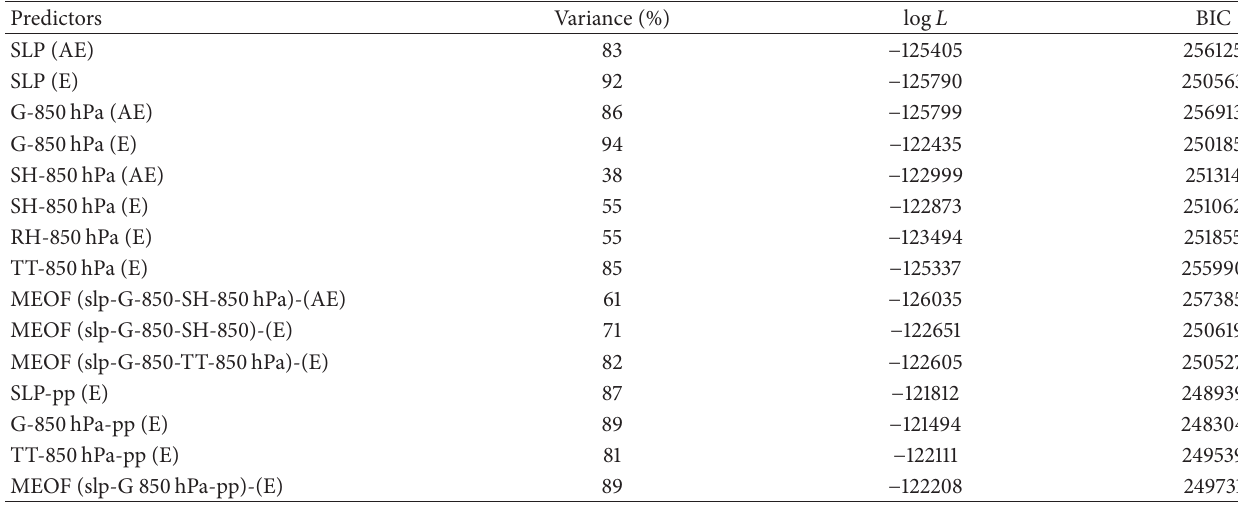
Table 3: Fitting by NHMM with seven states of precipitation at the 19 stations, taking into account as predictors (first 10 PCs) for EOF or MEOF decomposition; log 𝐿 is log likelihood and BIC represents Bayesian Information Criterion.